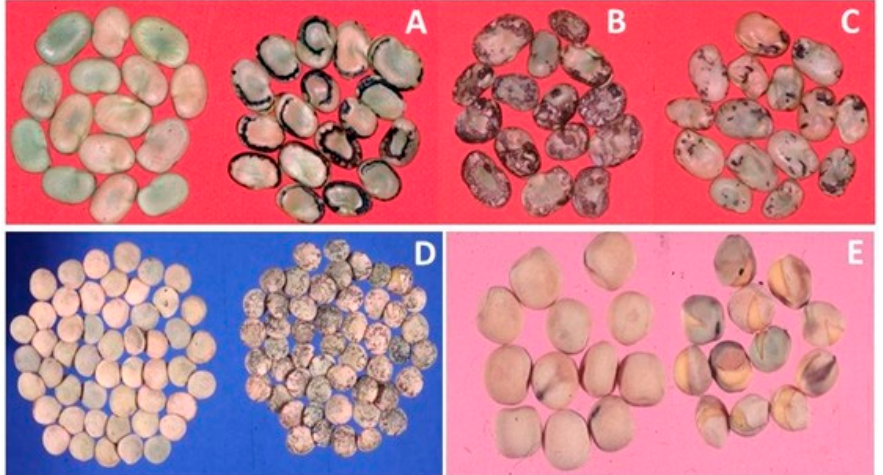
Figure 4. Symptoms of necrosis, size reduction, and malformation in seeds of faba bean, virus-infected (right) and healthy (left): causal viruses are broad bean stain virus (BBSV) ( A ), broad bean mottle virus ( B ), and bean yellow mosaic virus ( C ). Symptoms of necrosis in lentil seeds caused by BBSV ( D ), virus-infected (right), healthy (left). Cracking caused by pea seed-borne mosaic virus (PSbMV) in pea seed ( E ), virus-infected (right), healthy (left).